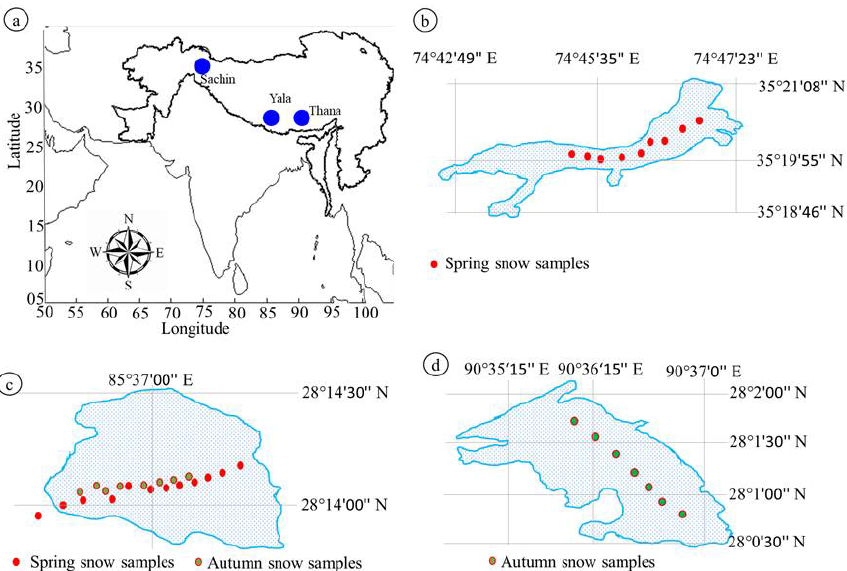
Figure 1. Study area map. (a) Locations of selected glaciers in the Himalayan Karakoram and Hindu Kush region. (b) The Sachin glacier in Pakistan. (c) The Yala glacier in Nepal. (d) The Thana glacier in